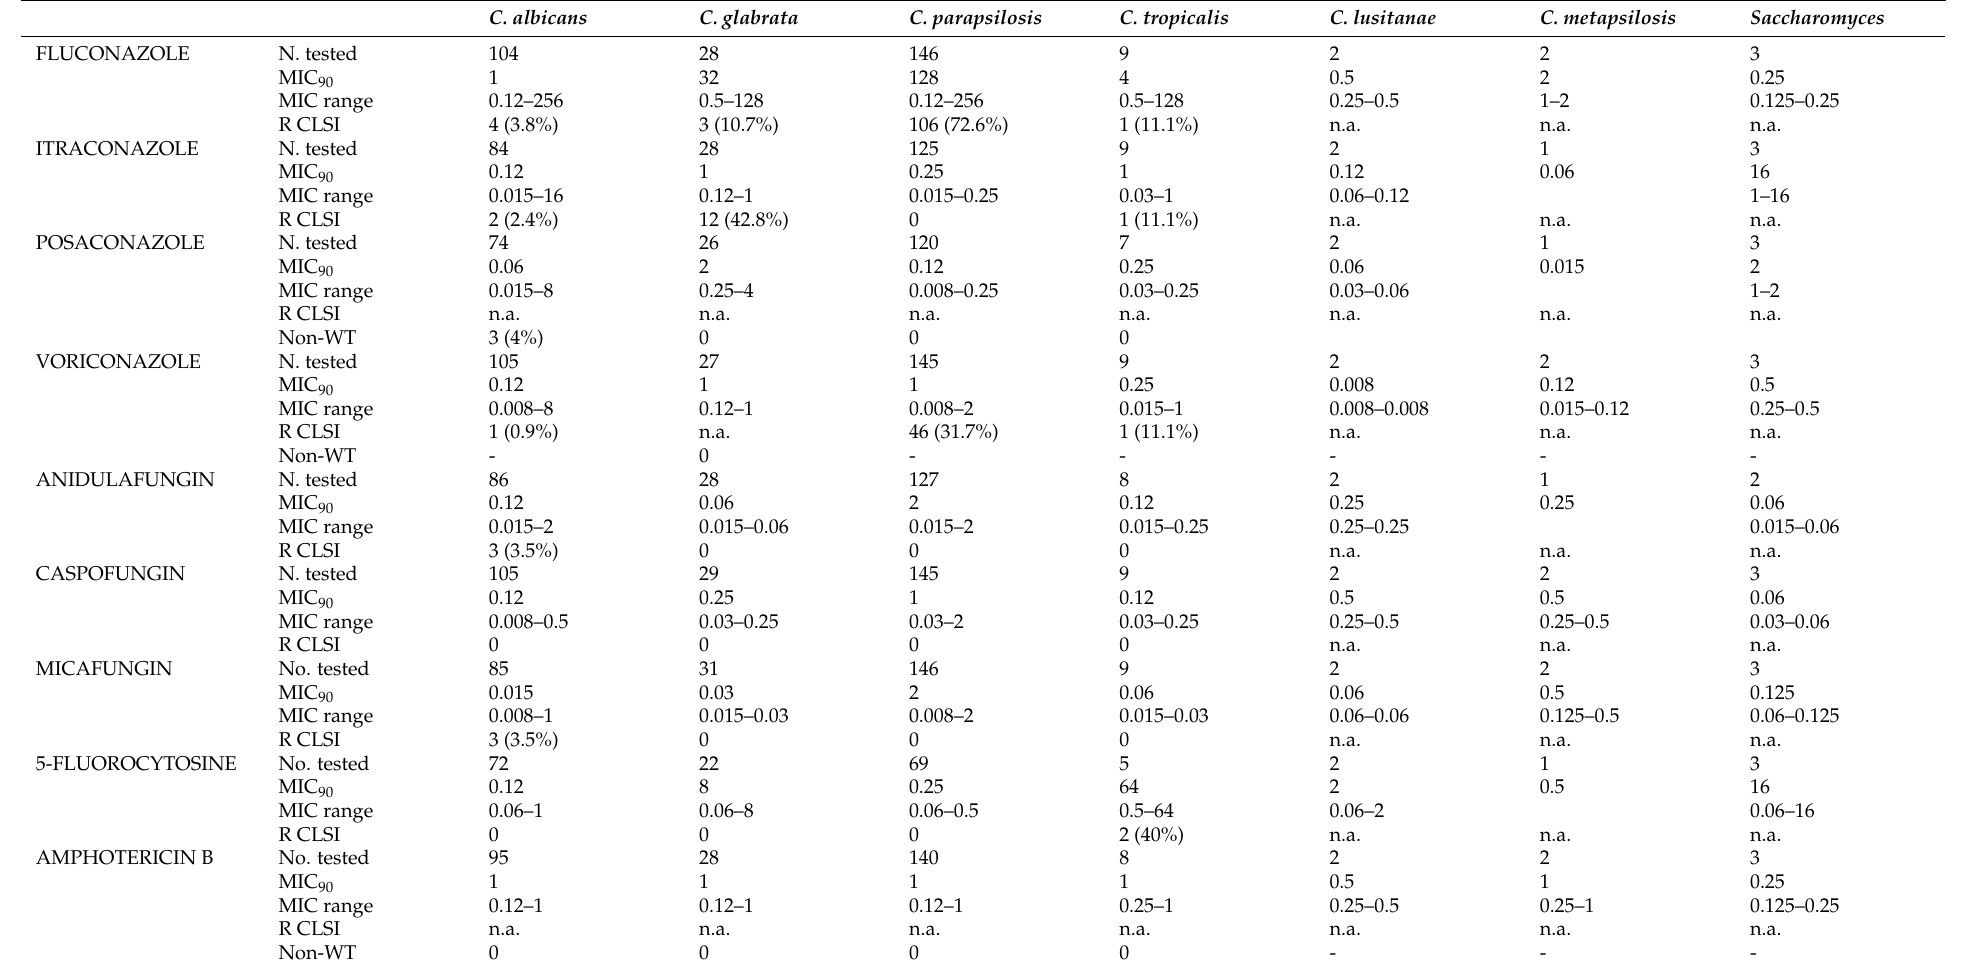
Table 4. MIC 90 , MIC range, number of resistant isolates according to CLSI species-specific breakpoints (R CLSI) or non-wild type (non-WT)